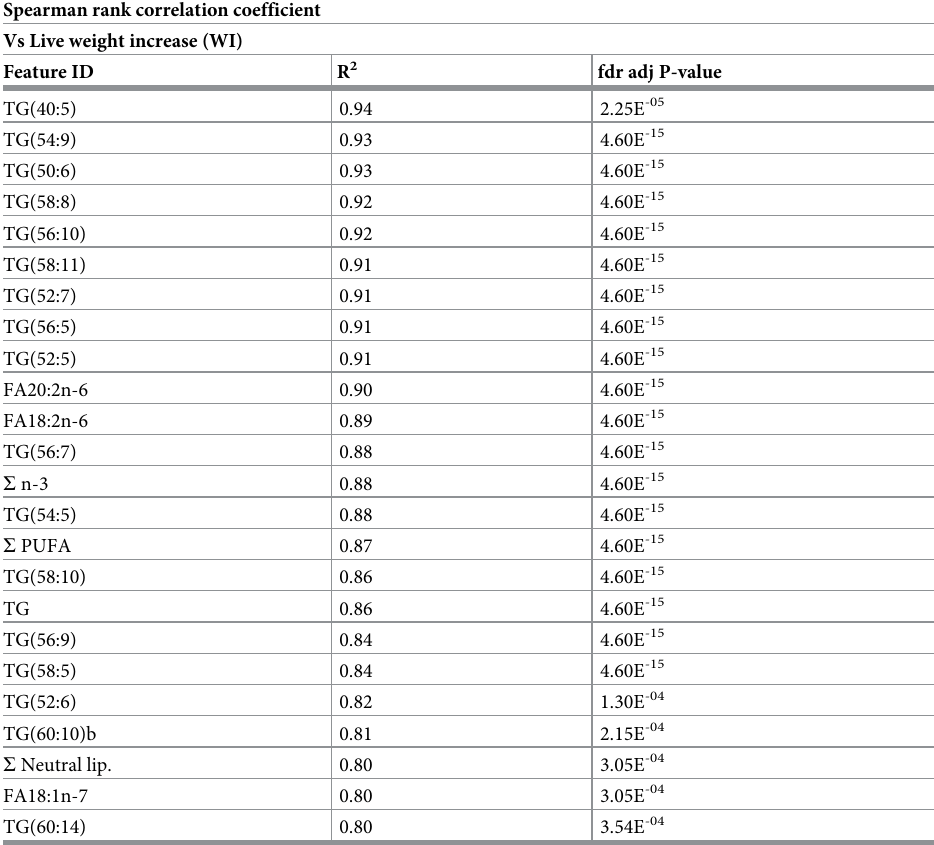
Table 4. Spearman rank correlation coefficients of lipids highlighted from the dataset analysed in this study and spat live weight increase (WI). The reported p-values are adjusted for multiple comparisons [59]. Spearman rank correlation